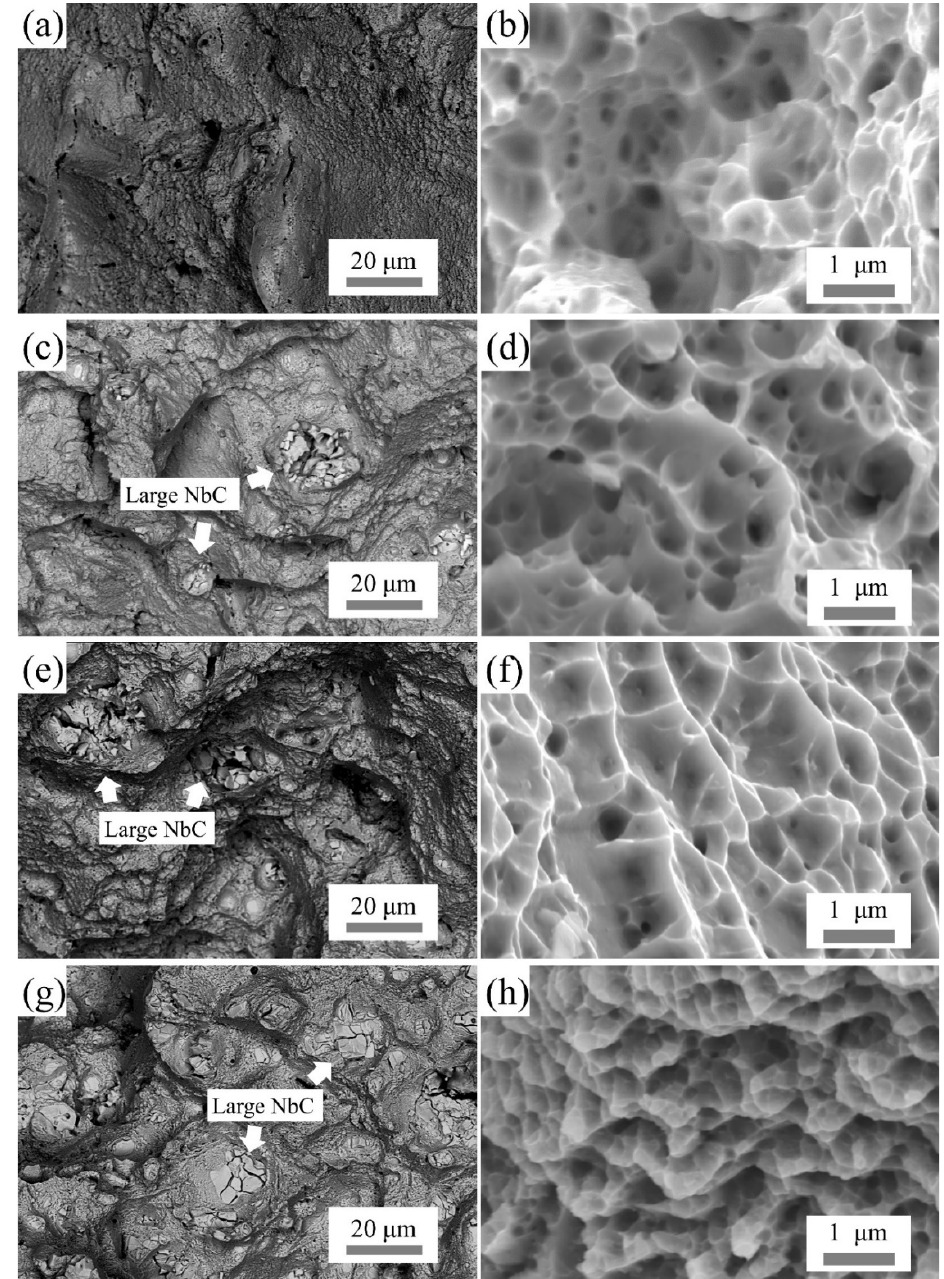
Figure 11. Fracture surfaces of STA specimens. ( a , b ) without NbC, ( c , d ) 0.5% NbC, ( e , f ) 1.0% NbC, and ( g , h ) 5.0% NbC.